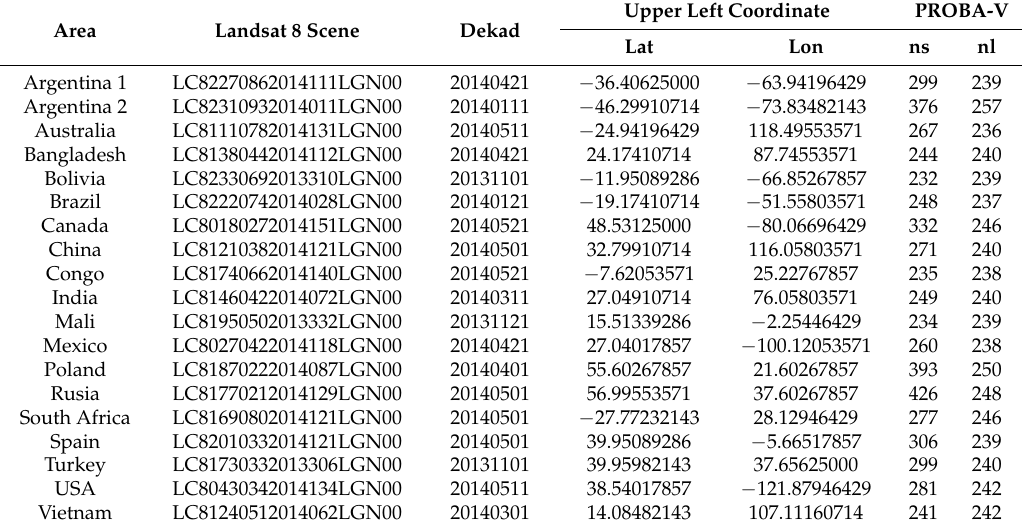
Table A2. Landsat 8 scenes of the 19 test regions selected worldwide were used to refine the threshold levels. As much as possible, cloud free scenes were selected. The corresponding PROBA-V dekad and the upper left corner coordinate are given with the corresponding number of samples (ns) and lines (nl).